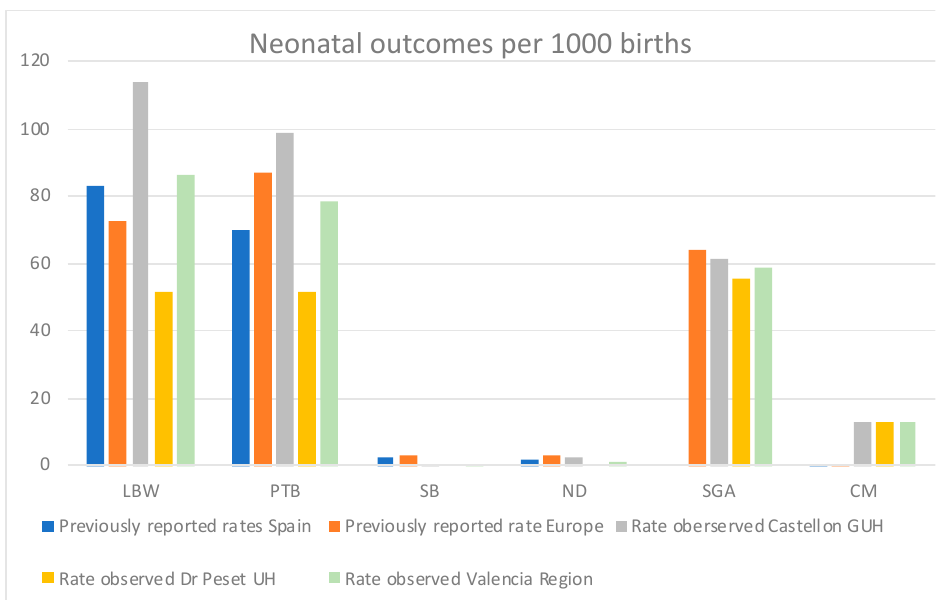
Figure 5. Comparative on the incidence rates of neonatal outcomes estimated in the Valencian study versus rates reported in previous literature for Spain and Europe overall. Previously reported rates for SGA in Spain are not available. Previously reported rate of LBW for Europe is an average of the rates reported by the UN, WHO, and UNICEF [13].